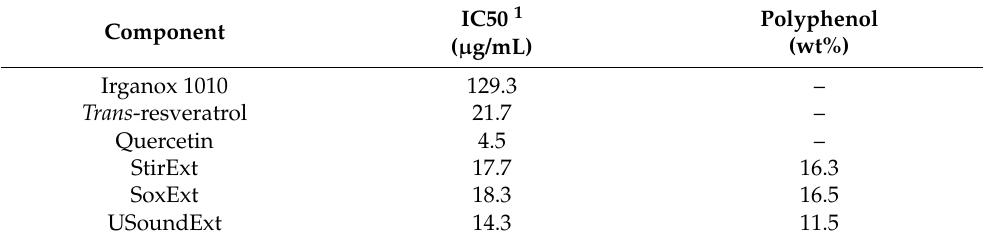
Table 2. Antioxidant activity and polyphenol content of the grape peel extracts produced, some of their components and the hindered phenolic antioxidant (I1010) used as